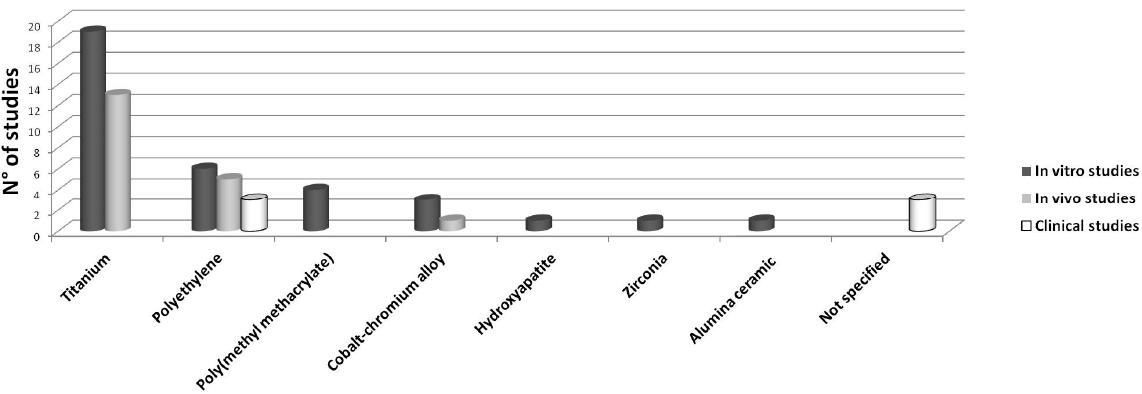
Figure 2. In vitro, in vivo and clinical studies dealing with different types of wear particles. The abscissa axis indicates the type of particles, while the ordinate axis indicates the number of studies dealing with each type of particles.